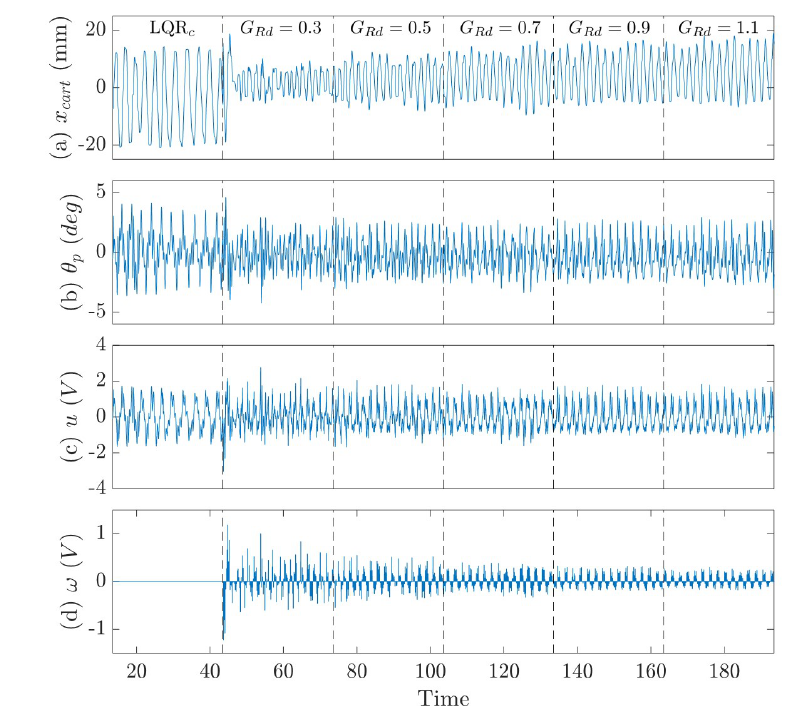
Figure 11. Experimental results for Dual-loop Controller with SPSHI. The overall control, u , and SPSHI control ω are shown in Figure 11c,d, respectively. The SPSHI signal is 0 in segment I since only LQR Rc is active. The outer-loop is activated, starting from segment II. As G Rd increases, the SPSHI control decreases and cart displace- ment magnitude increases. The mean absolute values of the cart displacement, overall control input voltage, and SHI voltage in Figure 11 are summarized in Table 4. The data in Table 4 are plotted in Figure 12.